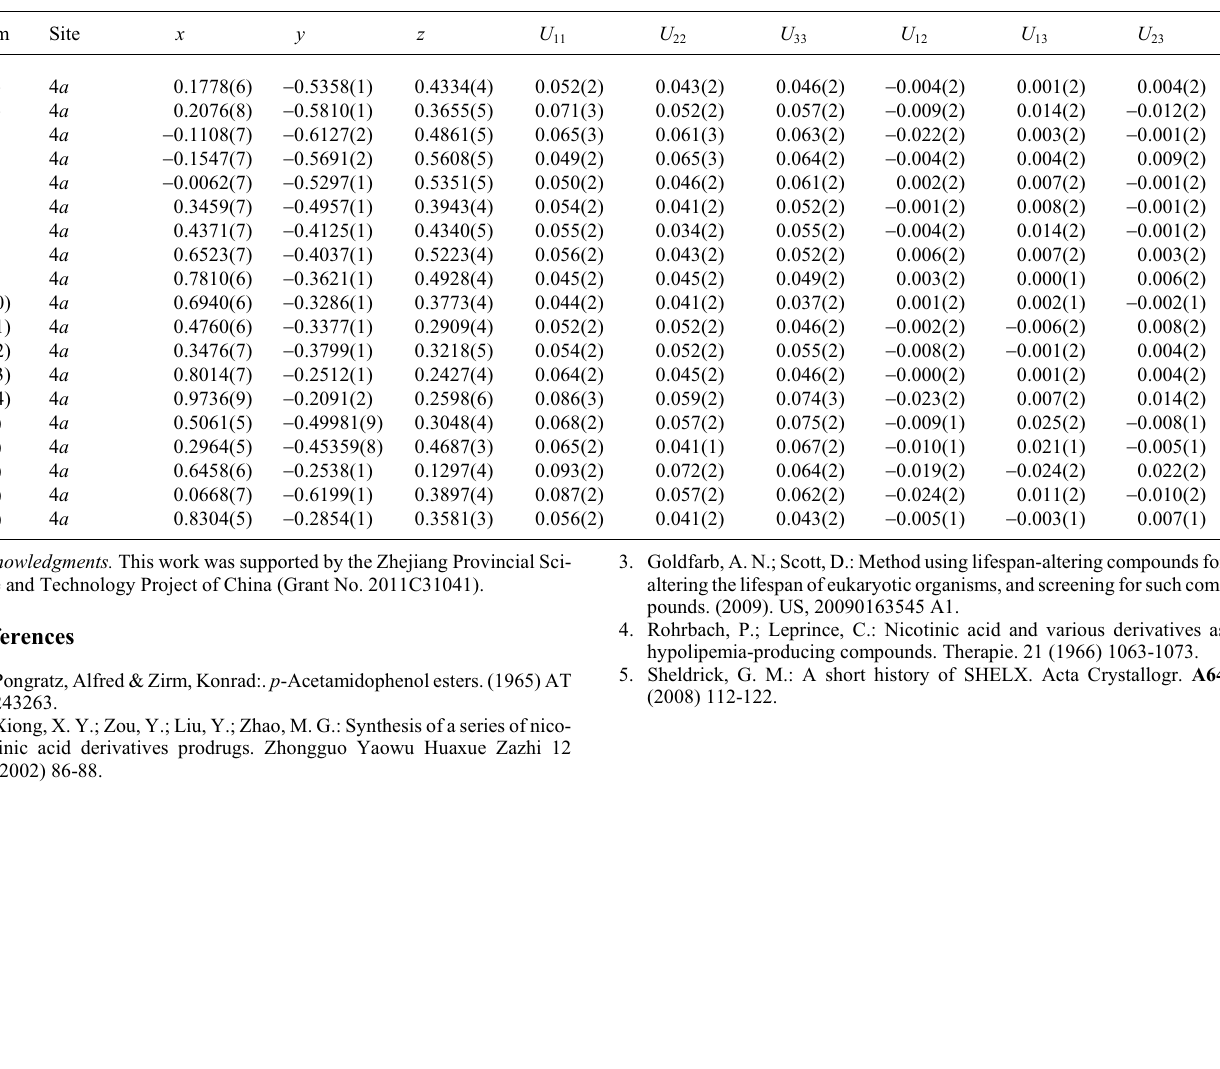
Table 3. Atomic coordinates and displacement parameters (in Å 2 )